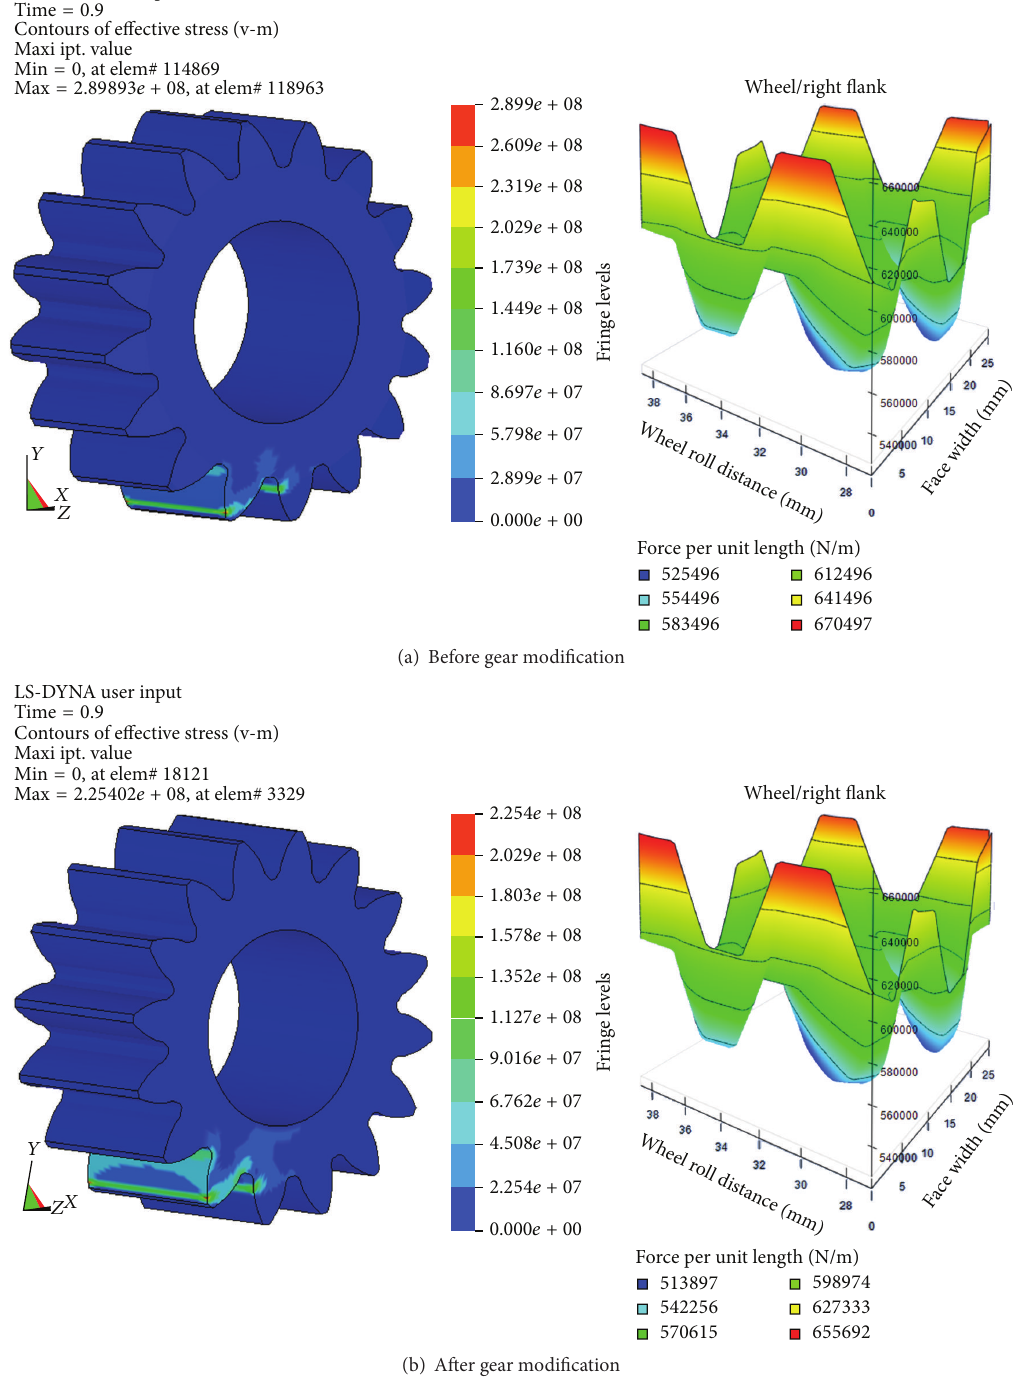
Figure 5: Distribution of dynamic effective stress based on ANSYS LS-DYNA and loading force applied to main gear per unit length based on MASTA before and after gear